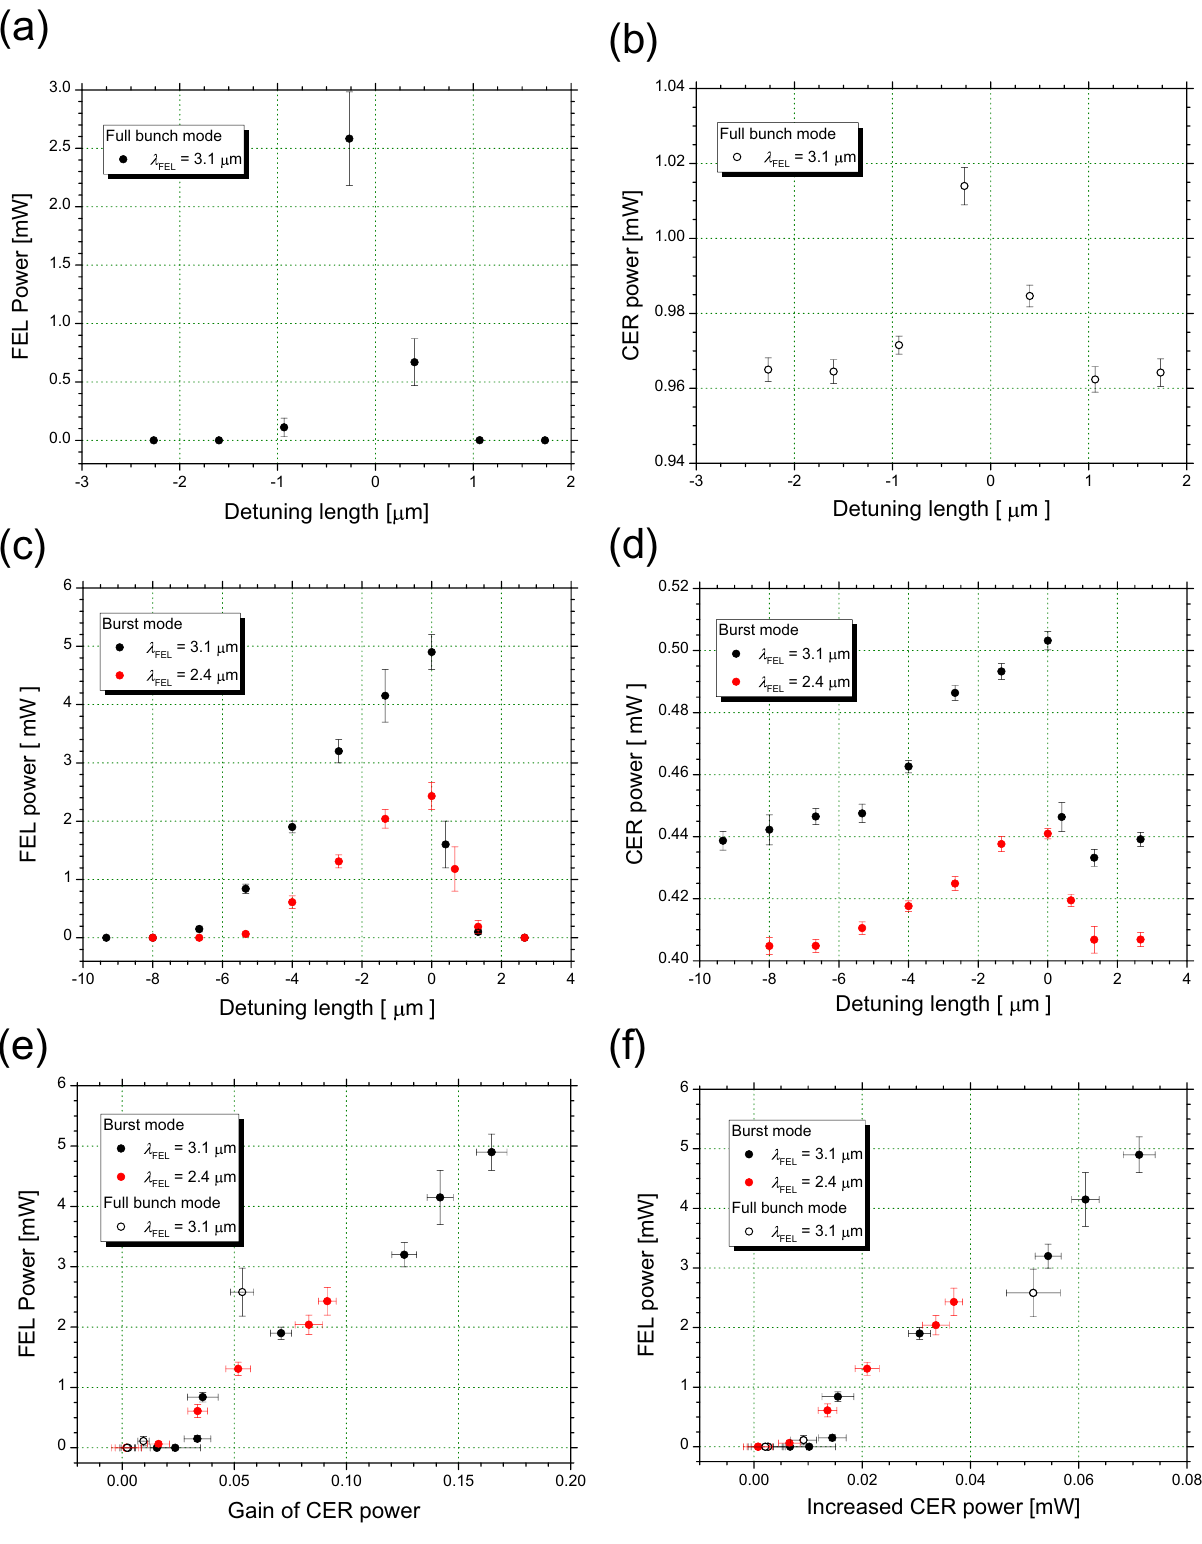
Figure 5. Relationship between CER and FEL powers with optical cavity detuning. Dependence of FEL power ( a ) and CER power ( b ) on detuning length in full bunch mode. Dependence of FEL power ( c ) and CER power ( d ) on detuning length in burst mode. Black and red circles represent data for FEL wavelengths of 3.1 and 2.4 μm, respectively. Medians of FEL detuning curve were − 1.70 and − 1.16 μm for FEL wavelengths of 3.1 and 2.4 μm, respectively. Medians of CER detuning curve were − 2.15 and − 1.39 μm for FEL wavelengths of 3.1 and 2.4 μm, respectively. Data of CER power and error bars in ( b ) and ( d ) represent average value and dispersion for 30 s, respectively. Dependence of gain of CER power ( e ) and net increment of CER power ( f ) on FEL power. Black and red symbols represent data for FEL wavelengths of 3.1 and 2.4 μm, respectively. Solid and open circle symbols represent data in burst and full bunch modes,